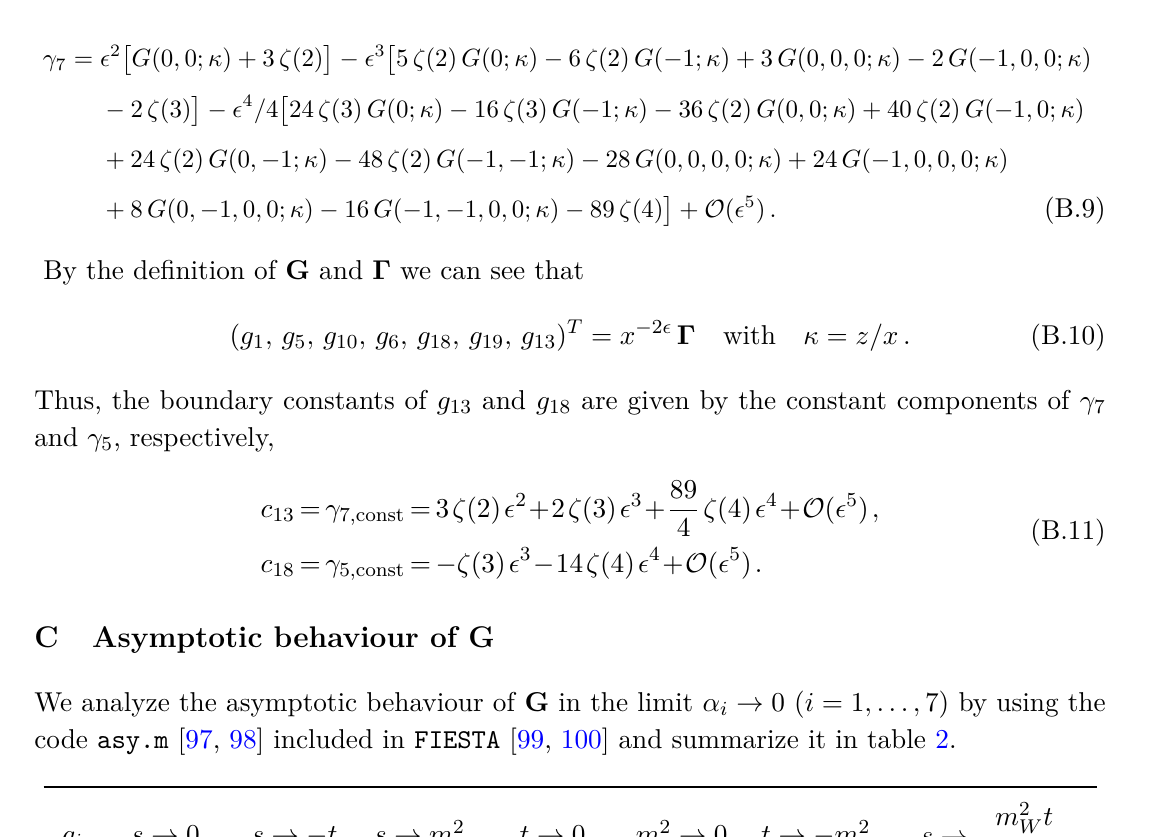
Table 2. The kinematic limits s → 0 , s → m 2 and m 2 → 0 correspond to α i → 0 , i = 1 , . . . , 7 , respectively. The chechmark means the MI is ‘ analytic, while the cross singular, in the corresponding limit